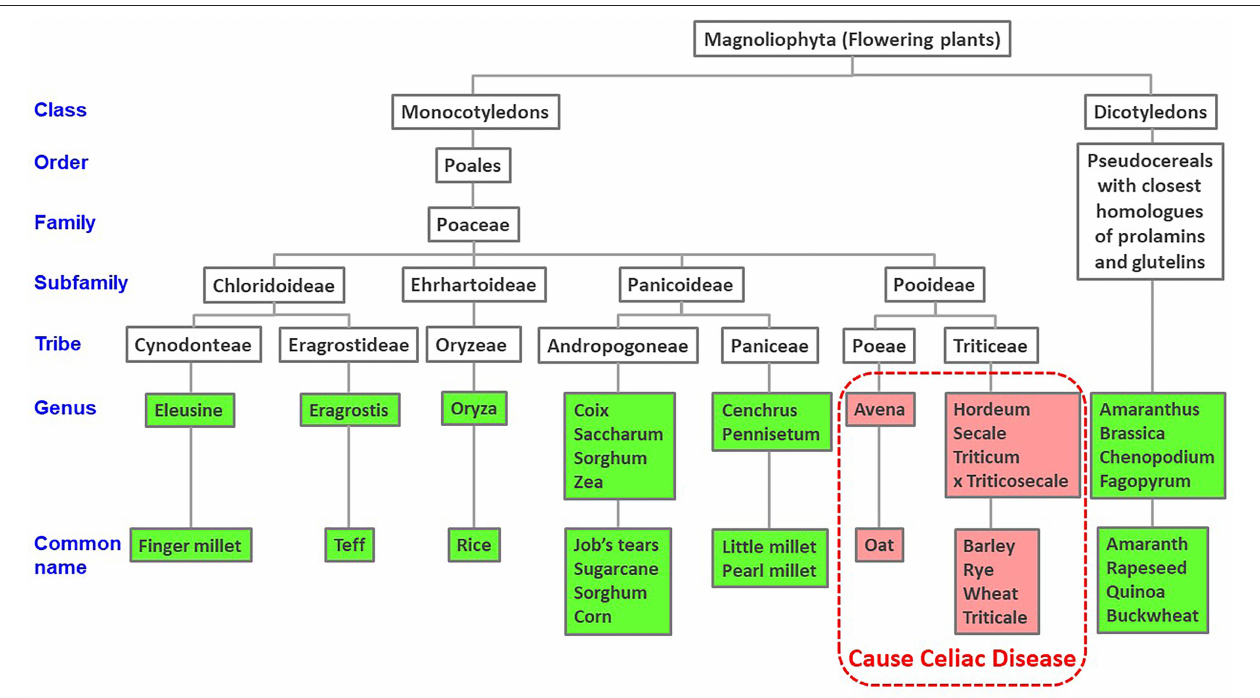
FIGURE 1 | Taxonomic tree of cereal and dicotyledonous plants based on NCBI taxonomy. Published evidence of CeD safe foods show reactions only to grains of the Pooideae subfamily of grasses.